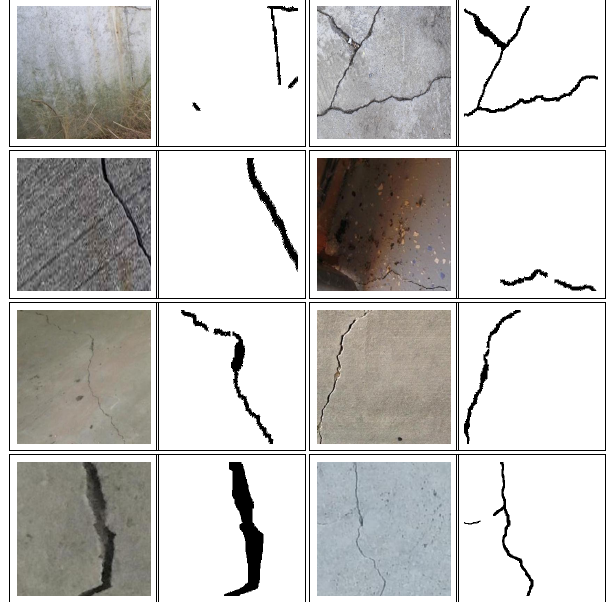
Figure 3. Sample RGB images from training set and their pixel-level annotated binary ground truth images denoting crack